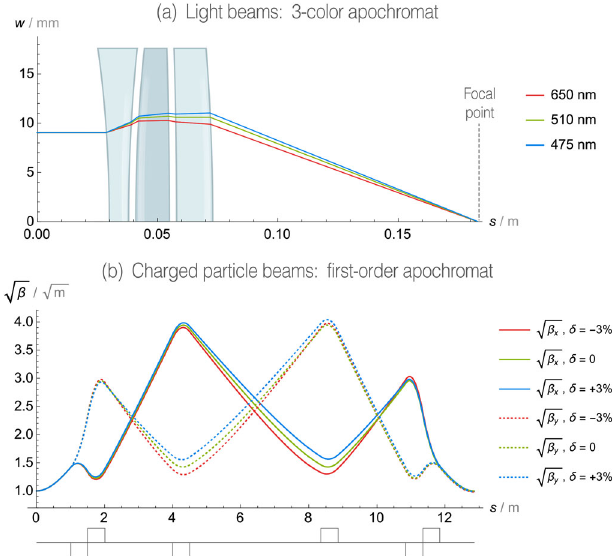
FIG. 1. Plot (a) shows width w of three light beams vs the optical axis s for a 3-color apochromat. Plot (b) shows transverse ffiffiffi p β beam size in x and y vs s for a first-order apochromat. Both apochromats use the same principle: beams of different color/ energy are focused differently through the system, but end up focused to the same point. However, the two examples are different in a subtle way: In plot (a) three distinct colors are focused to the same point, leaving intermediate colors slightly unfocused. This is how achromatic lenses for light optics are often designed. In contrast, in plot (b) the nominal energy is perfectly focused, and the focusing error is canceled to first order in δ , leaving small-offset energies well focused. In this paper, we study arbitrary order apochromats for charged particle